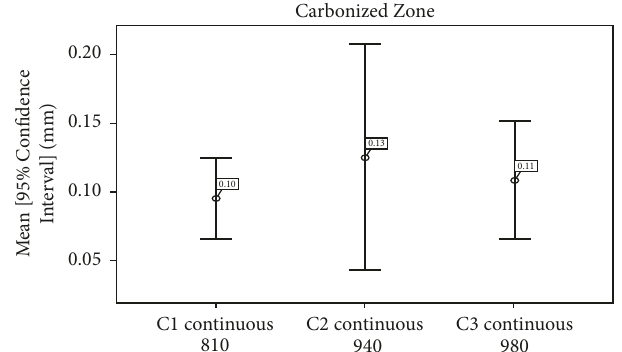
Figure 7: Average carbonized zones of groups C1, C2, and C3.